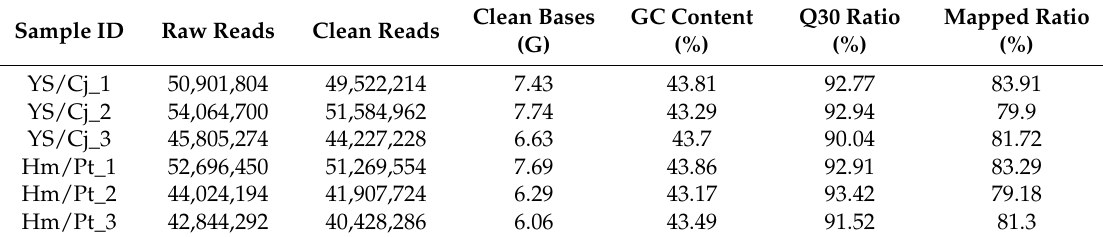
Table 1. Statistics of sequencing data of the six